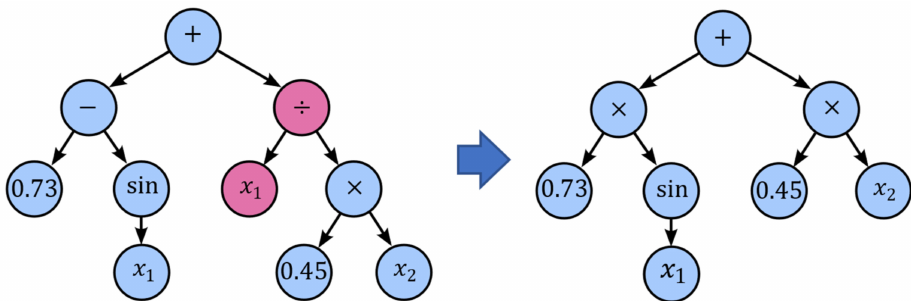
Figure 13. Hoist